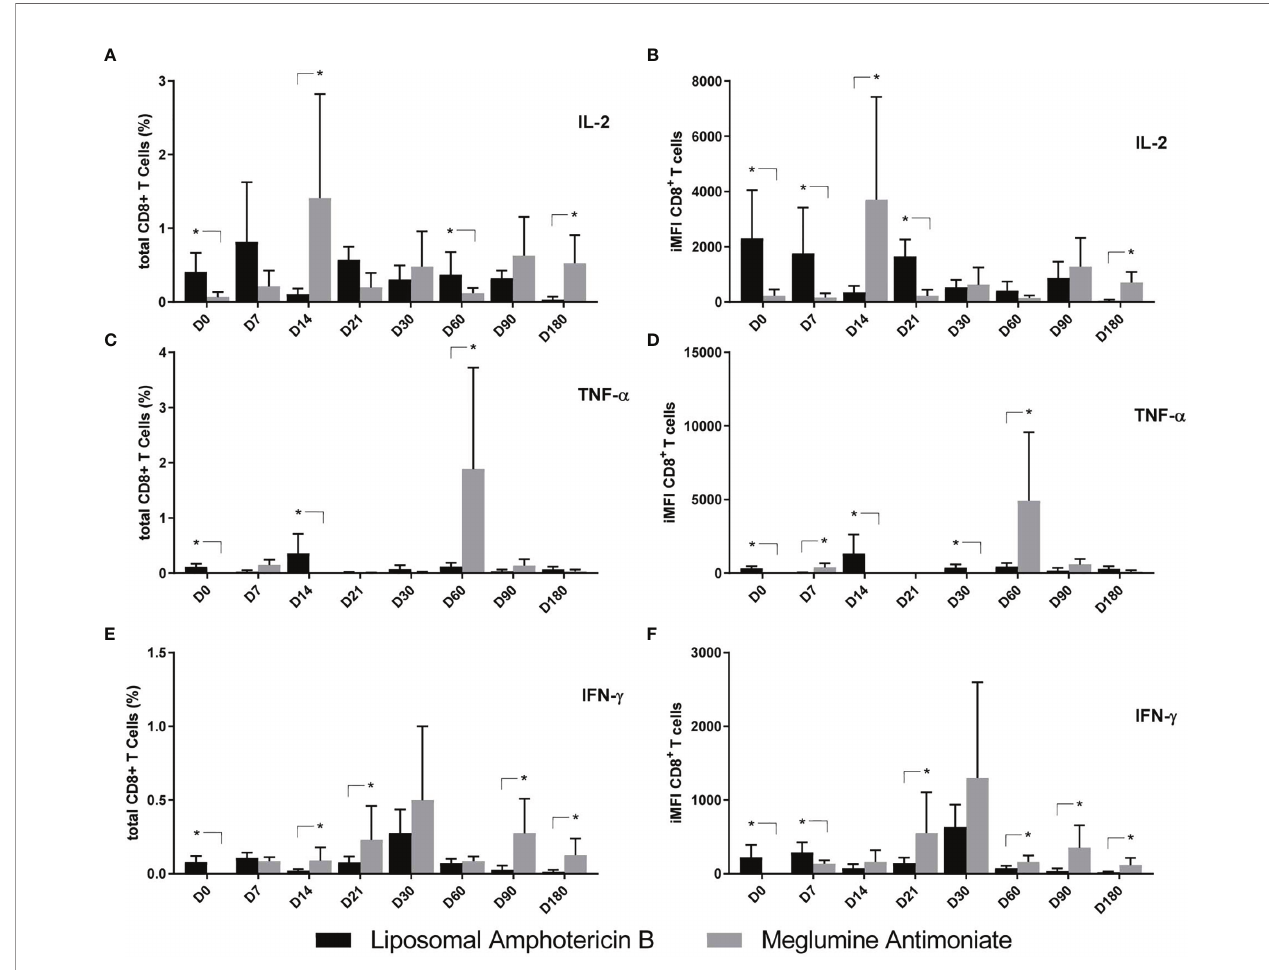
FIGURE 8 | Cytokine production by CD8 + T cells of patients treated with meglumine antimoniate (Glucantime ® ) and amphotericin B Frequency (A – C) and integrated mean fl uorescence intensity (iMFI) (D – F) of T CD4 cells producing IL-2, TNF- a , and IFN- g from patients treated with Glucantime ® (N = 8) and amphotericin B (N = 5). The frequencies and iMFI of each cytokine expressing phenotype were recorded after background subtraction of cells incubated without antigen [soluble Leishmania antigen (SLA)]. Results in the panel are expressed as means+SE. Asterisks and horizontal lines indicate statistical differences between treatments as disclosed by